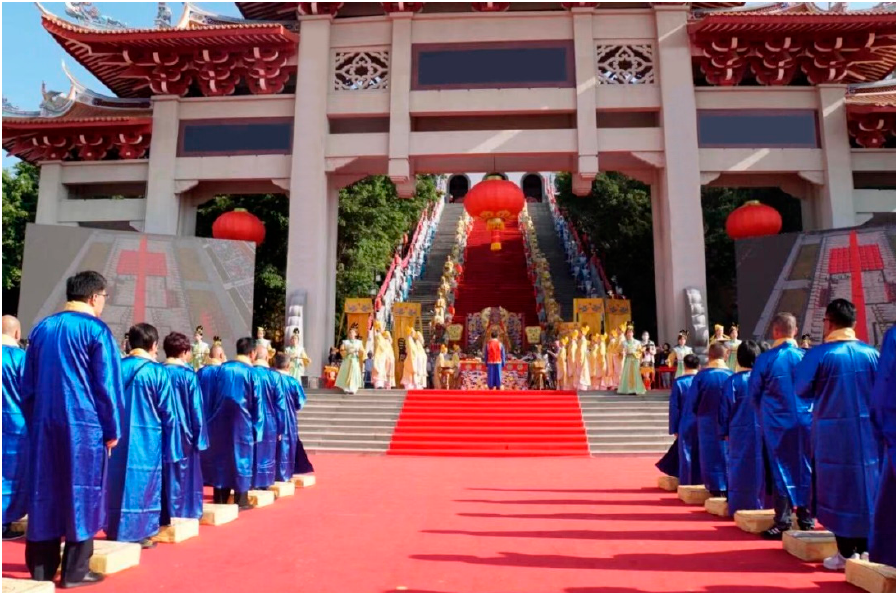
Figure 3. The leading and assistant sacrificers on the platform of the Central Hall. Source: the website of Meizhou ancestral temple https://weibo.com/mzmz323?reFigure1005055013.is_all=1#_rnd16106 41535373. Accessed on 10 July 2020. Reprinted with permission from the temple board of Meizhou ancestral